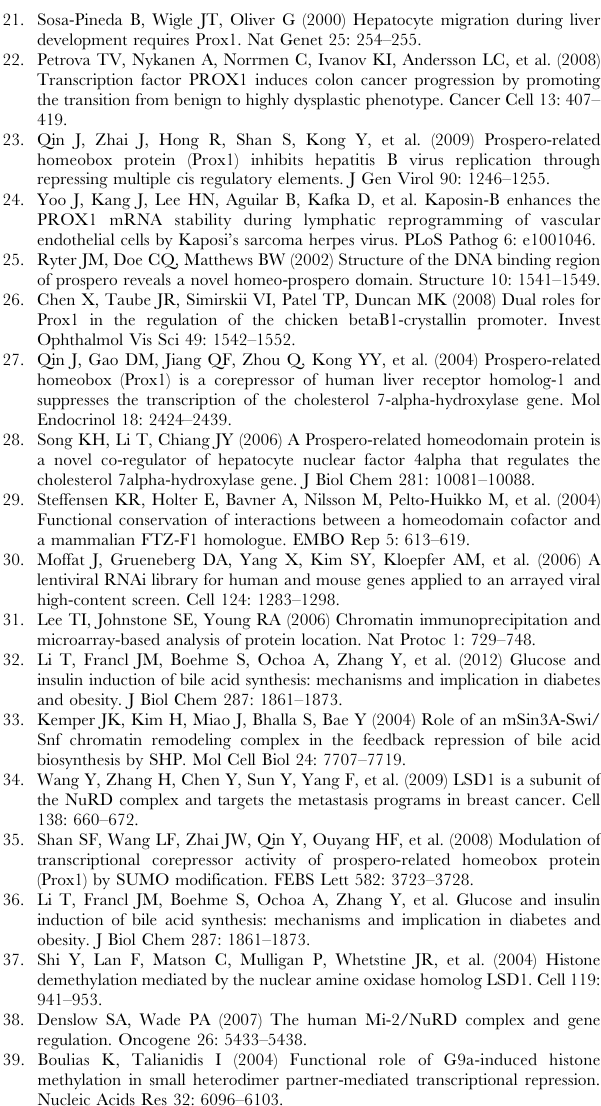
Figure S2 Association of endogenous Prox1 with LSD1/ NuRD complex in HepG2 cells. HepG2 cells were subjected to co-immunoprecipitation assay using anti-Prox1 antibodies in the presence of DNaseI (0.1 m g/ m l) and RNaseA (0.2 m g/ m l). Co- immunoprecipitated HNF4 a and LSD1/NuRD complex compo- nents were detected in Western blot using corresponding antibodies as indicated. Table S1 LSD1/NuRD complex components identified by mass spectrometry in proteins